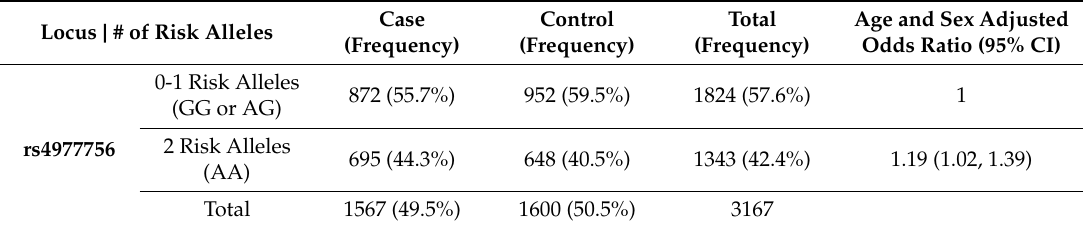
Table 2. Association between rs4977756 genotypes and POAG disease status (case vs. control), according to a recessive model of POAG risk. Analyses controlled for age and sex. * denotes a significant result for α =